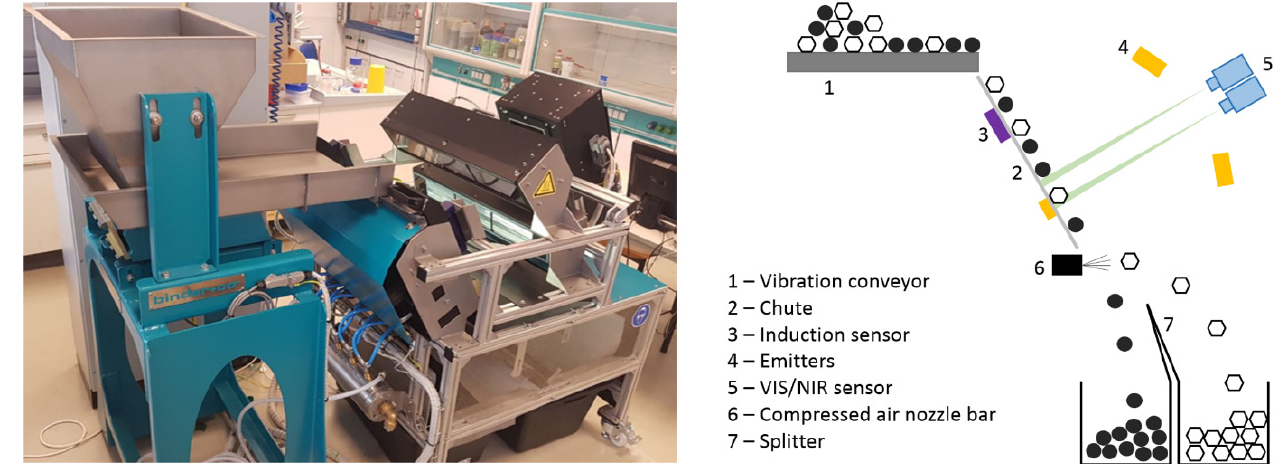
Figure 2. Experimental sensor-based sorting setup with the use of near-infrared spectroscopy.